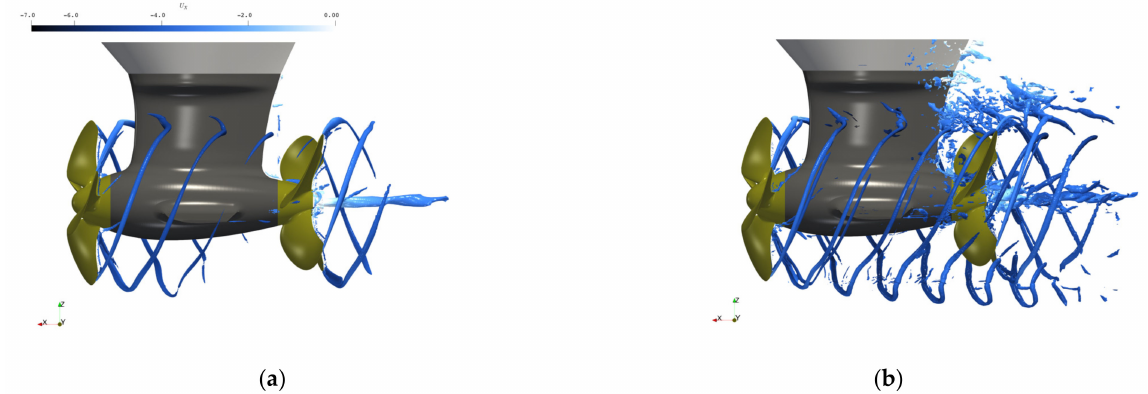
Figure 18. SCHOTTEL reference case 2. Comparison of RANS and ILES Q-criterion Q = 1 · 10 4 s − 2 at model scale on the same mesh: ( a ) RANS; ( b ) ILES.